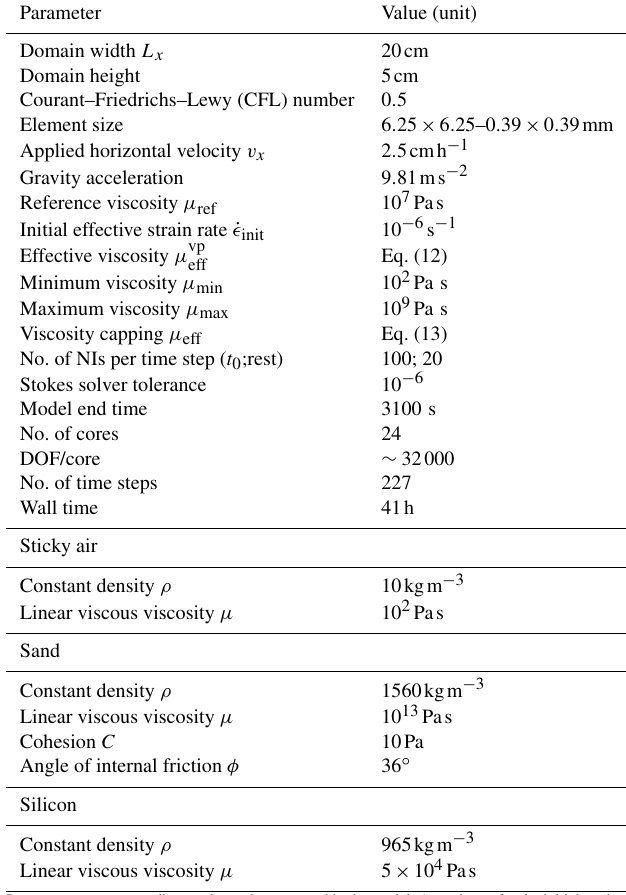
Table 5. The sandbox experiment model